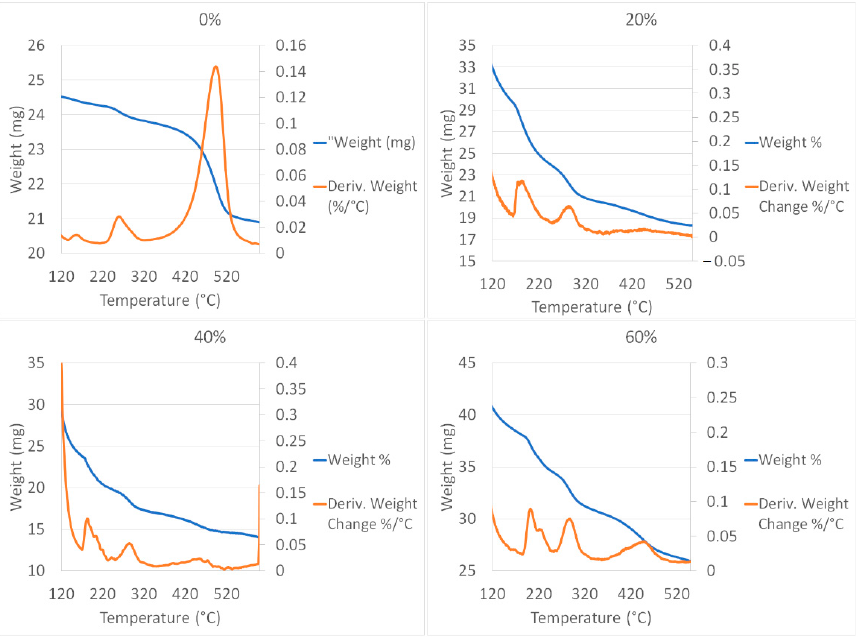
Figure 3. Thermogravimetric analysis (TGA) for 0, 20%, 40%, and 60% HA integration within the SA hydrogels.